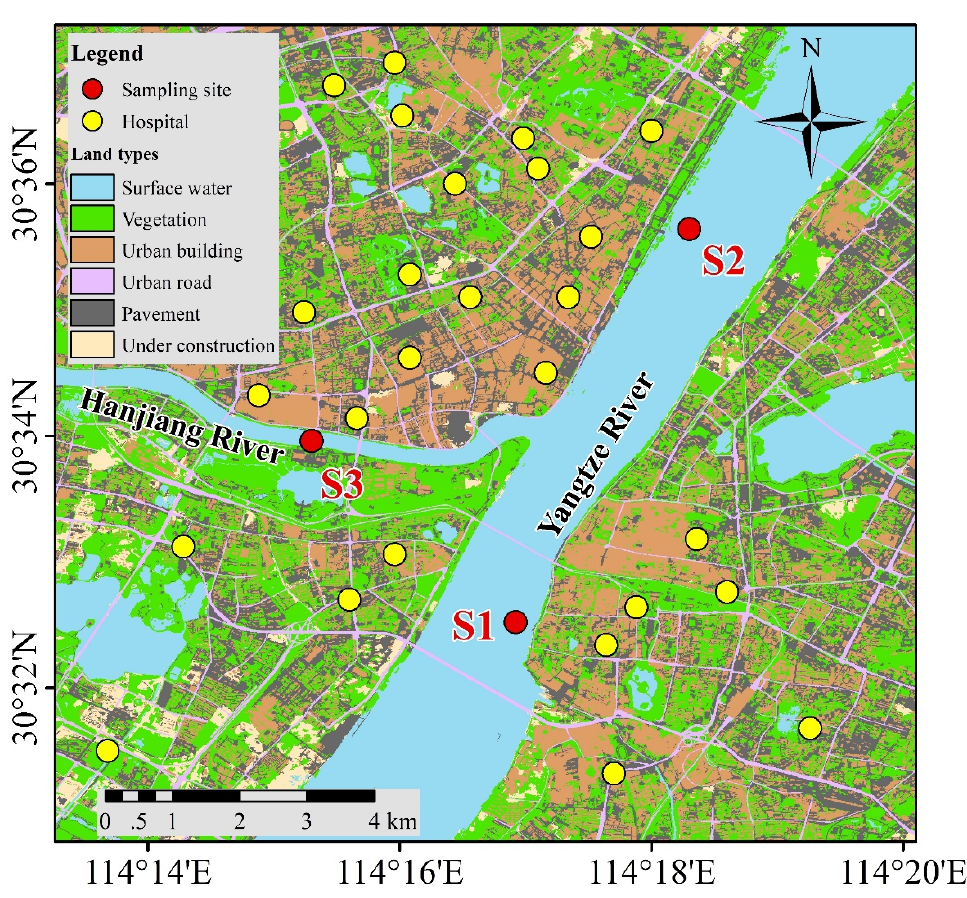
Figure 7. Map of sampling sites. Table 3. Concentrations of cations and anions in surface water samples (mmol/L). Table 3. Concentrations of cations and anions in surface water samples